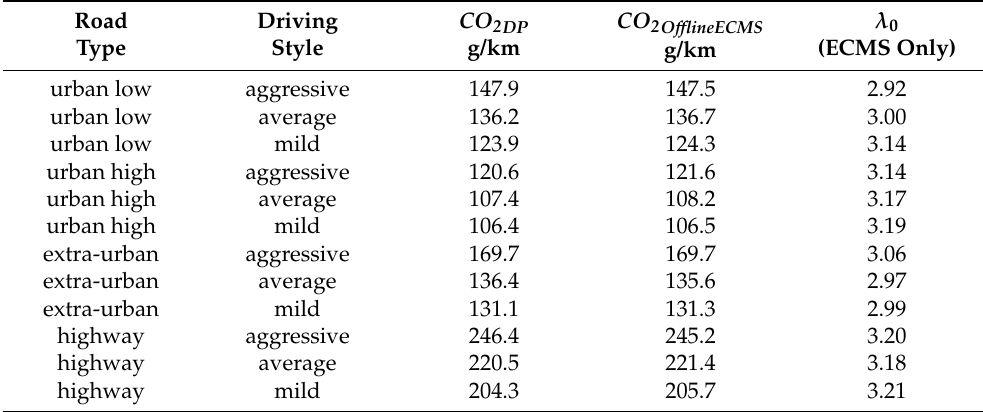
Table 2. Comparison of CO 2 emissions in Offline ECMS vs. DP (unlimited battery capacity).